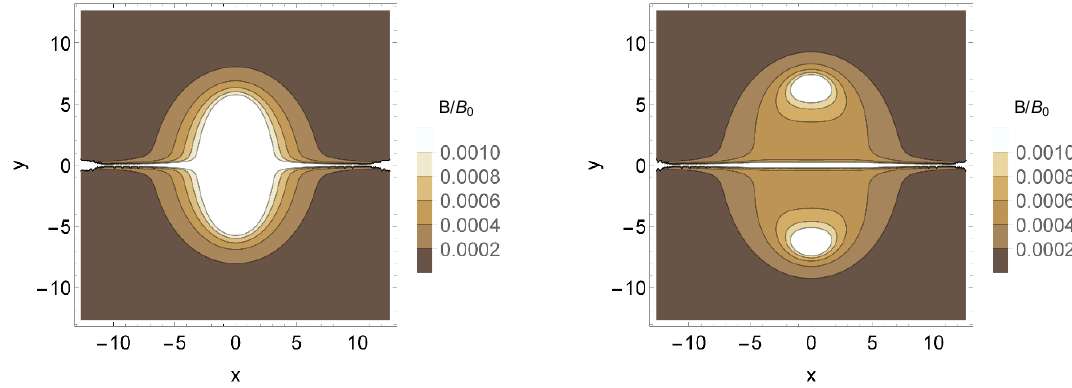
Figure 7 . (color online). The magnitude of the magnetic (cid:12)eld in the transverse plane from current free solution, i.e. eq. (4.1) using parameters (cid:12)xed in (6.7) for ! 1 = 0 : 05 ; ! 2 = 0 : 5 at (a) (cid:28) = 0 : 4 fm = c, and (b) (cid:28) = 5 fm = c. The height of the white areas is decreased with time.